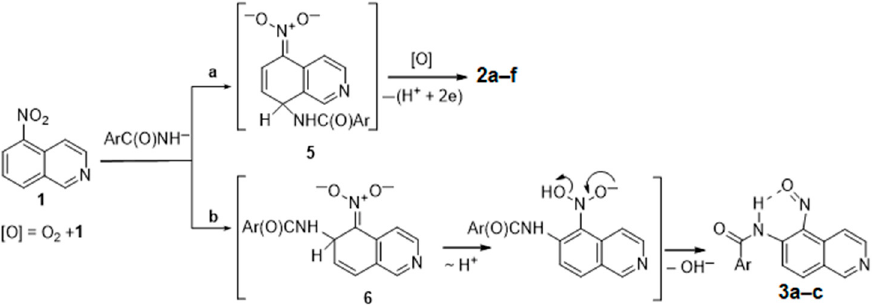
a Isolated yields after column chromatography. b The experiment was performed at room temperature. c The experiment was performed in presence of K 3 Fe(CN) 6 . d The experiment was performed at 60 ◦ C. e The reaction was performed under